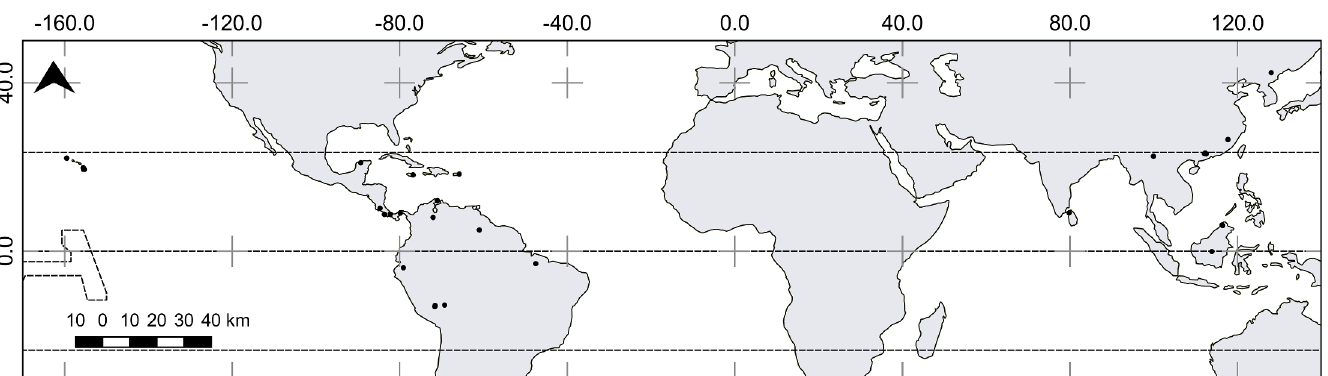
PLOS ONE | DOI:10.1371/journal.pone.0144253 December 3,